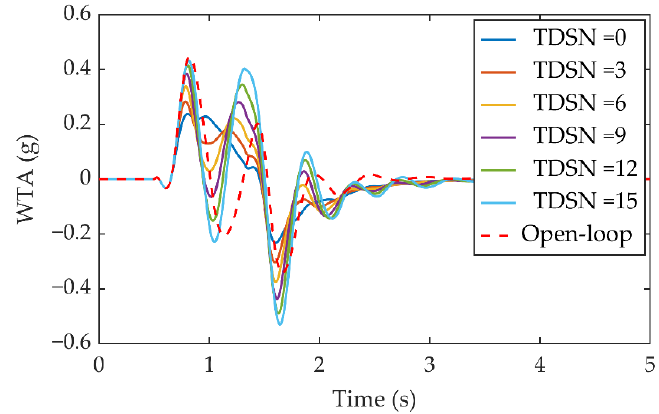
Figure 15. WTA corresponding to different TDSNs of gust sensor.